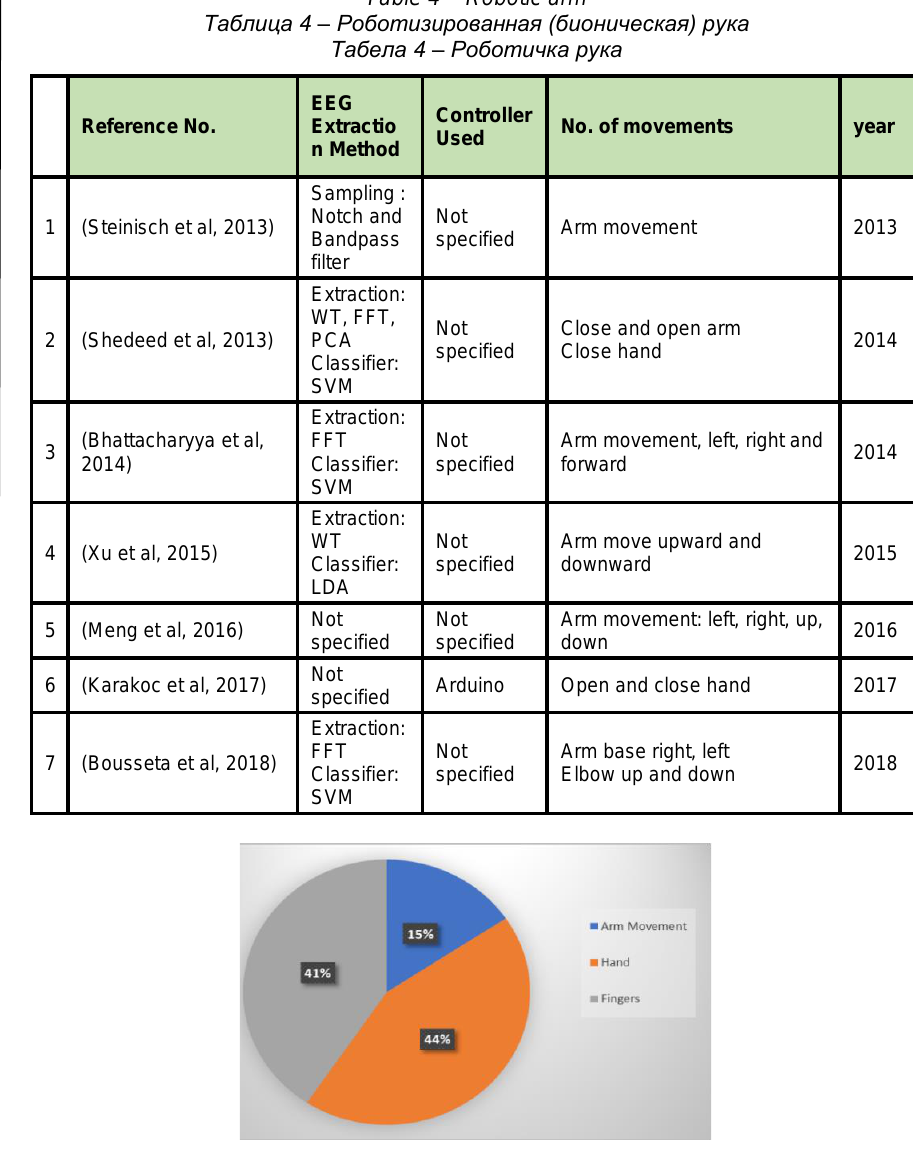
Figure 5 – EEG signal control in the prosthetic arm research studiesfrom Table 2 Рис. 5 – Управление сигналом ЭЭГ в исследованииях о протезировании руки